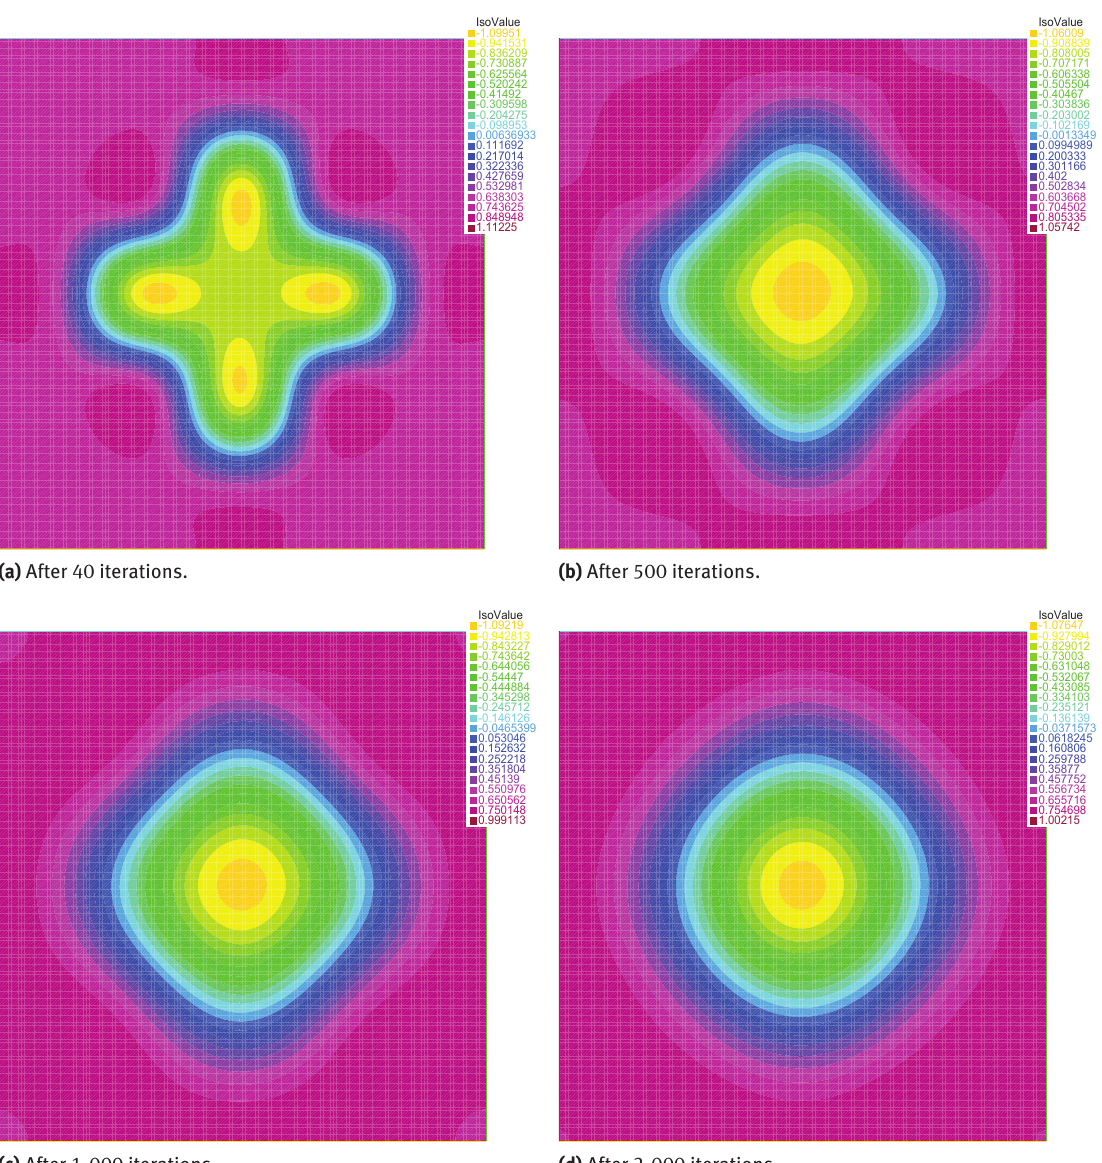
Figure 6: Results for k = 3, dt = 10 − 10